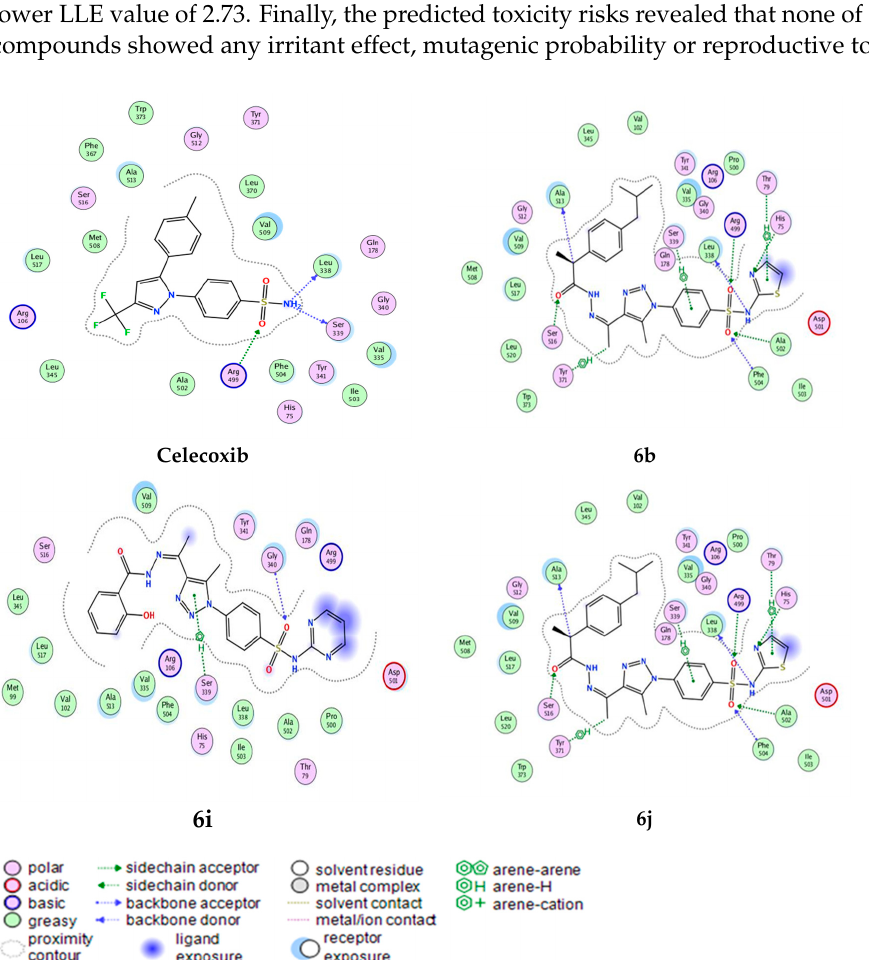
Figure 5. Two-dimensional style of docking solutions of the potential selective COX-2 target inhibitors, 6b and 6j ; and celecoxib as the cocrystallized ligand inhibitor in the active site of COX-2 (PBD code 3LN1). Lastly, the docking solution of compound ( 6i ) as a weaker selective COX-2 inhibitor to visualize its binding pattern with the same active site. Amino acid residues represented by the protein sequence code of three letters and numbers; interaction forces represented by green dotted lines which are categorized according to the description scheme associated with the figure.